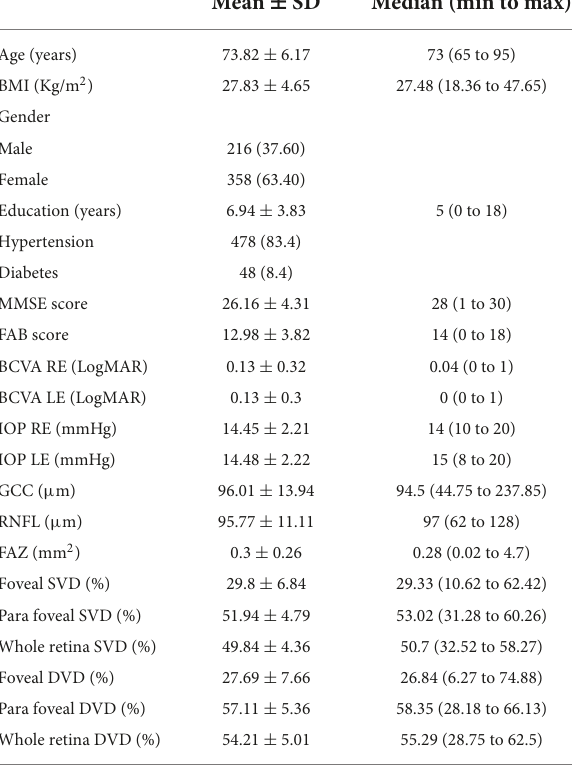
TABLE 1 Description of sociodemographic and variables of the whole sample.